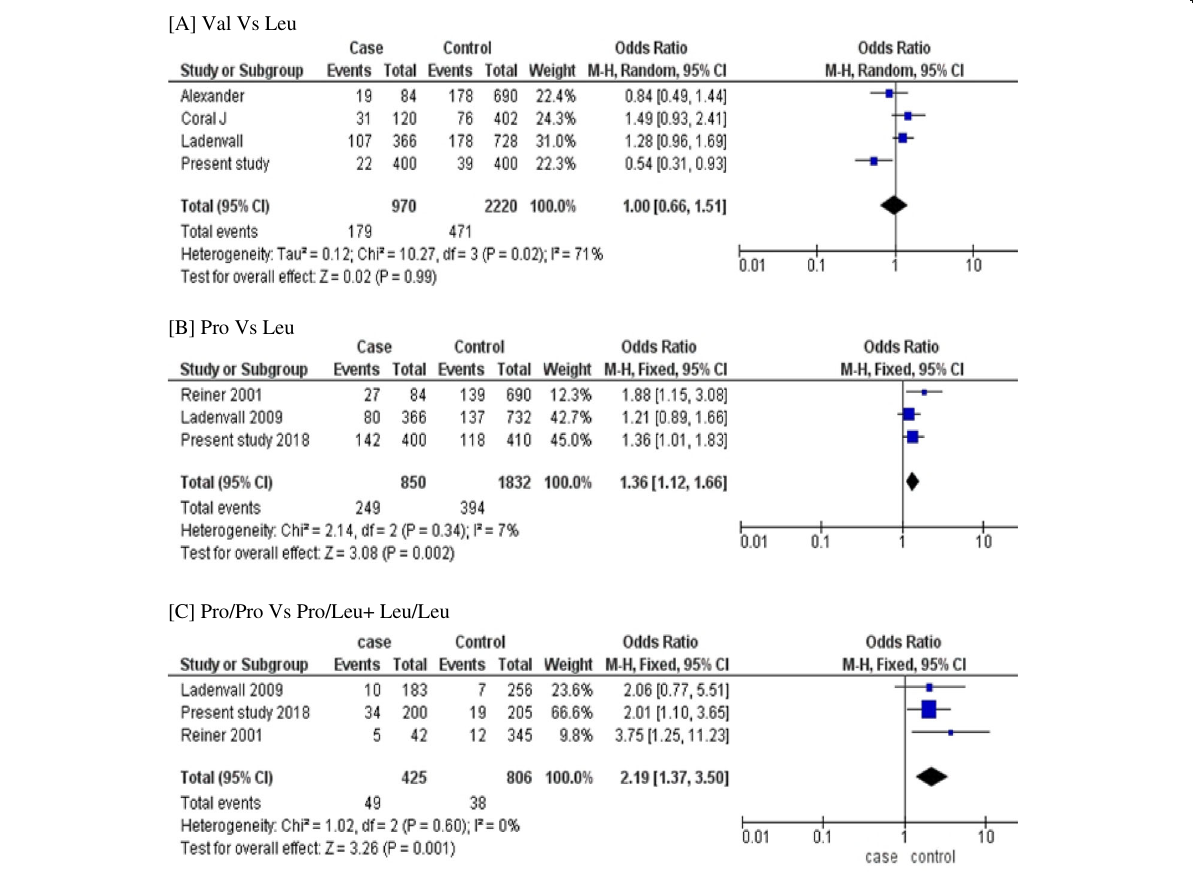
Fig. 2 Metanalysis of factor XIII gene variants. a c.103G > T (p.Val35Leu) (Val Vs Leu) ( b ) c.1694C > T (p.Pro564Leu) (Pro Vs Leu) ( c ) c.1694C > T (p.Pro564Leu) (Pro/Pro Vs Pro/Leu +